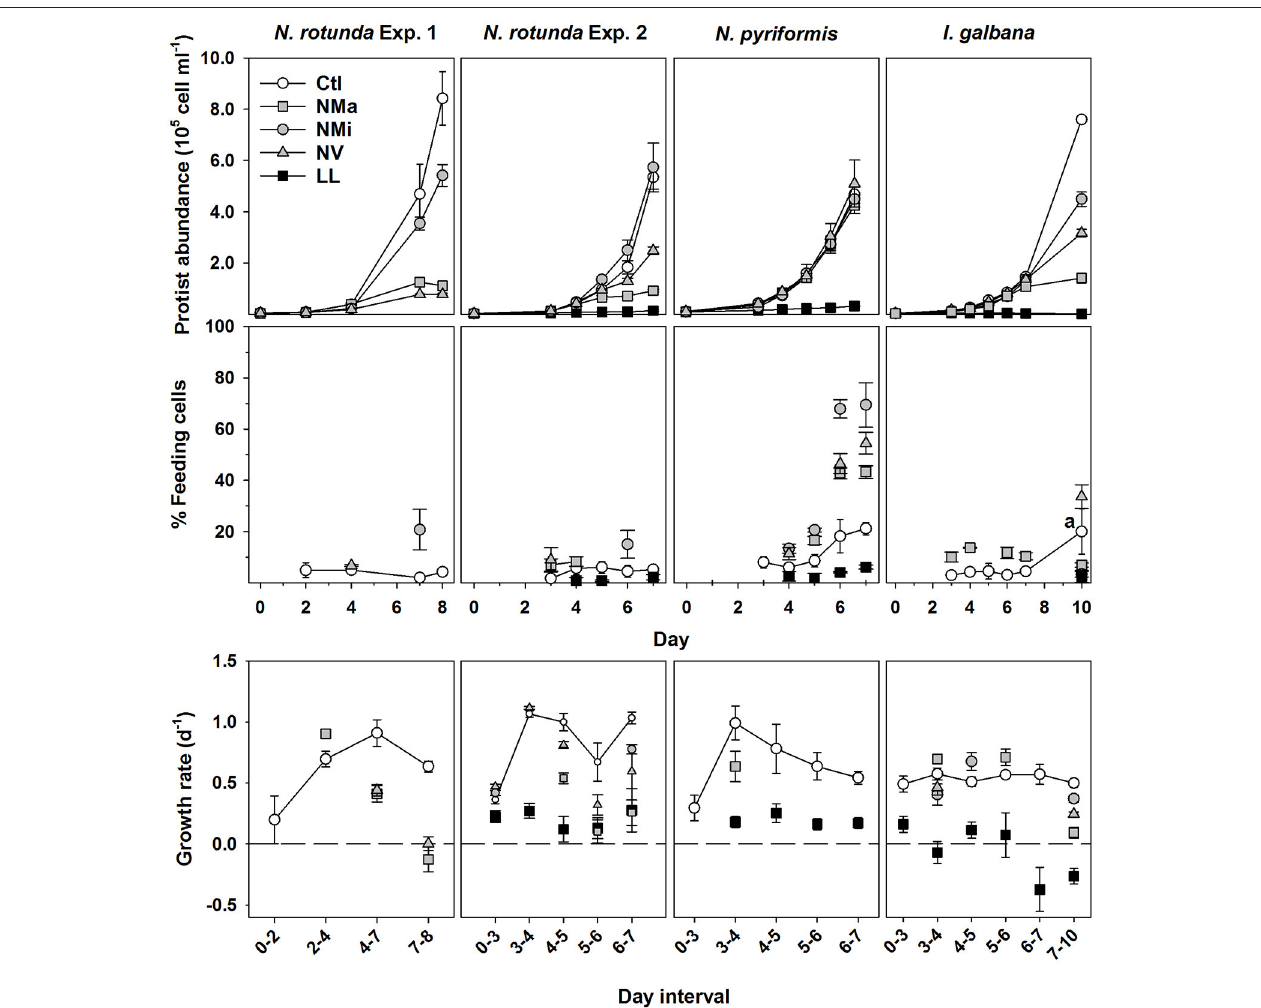
FIGURE 1 | Changes in phytoflagellate abundance, percentage of feeding cells and growth rate for N. rotunda Exp. 1 and 2; and the N. pyriformis and I. galbana experiments. In the plots for percentage of feeding cells and growth rate all time points for Ctl are plotted, while for the treatments only the time points with a significant difference to Ctl are plotted ( t -test; P < 0.05). a, at this time point only duplicate values were available for the control and statistics were not possible. Treatments – control (Ctl), and media without the addition of macronutrients (Nma), micronutrients (NMi) or vitamins